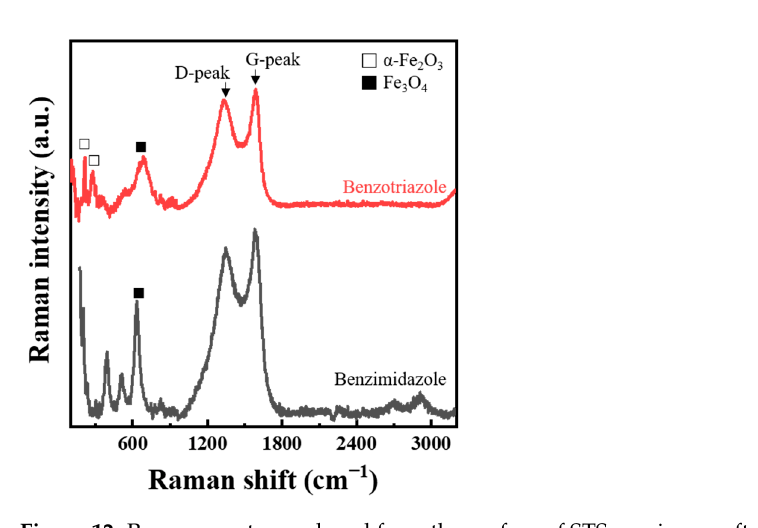
Figure 11. Raman spectra analyzed from the surface of STS specimens after immersion for 168 h in 1 M HCl solution at 298 K with α -terpineol, 1,8-cineole, and terpinen-4-ol of 0.75 g/L.